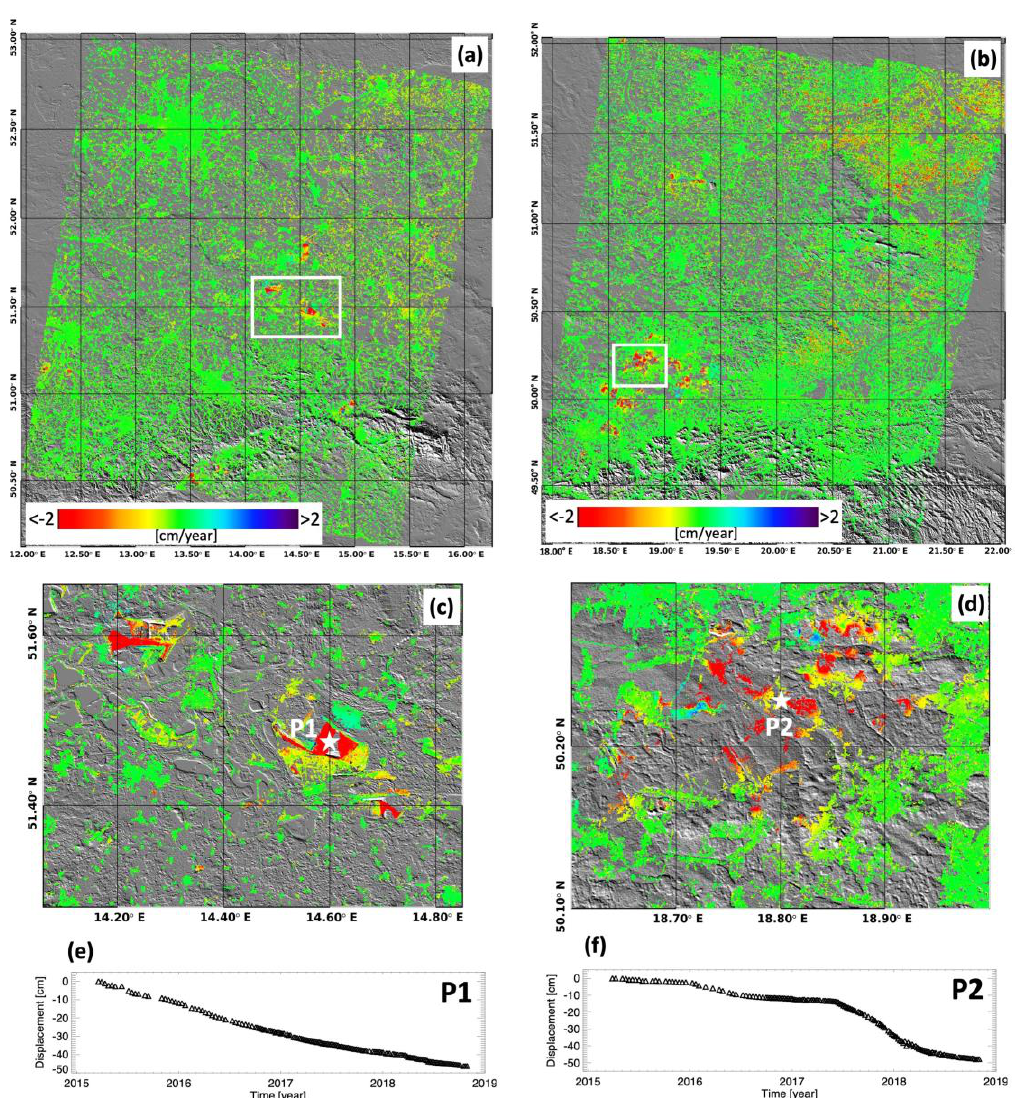
Figure 16. Zoomed-in views of the mean deformation velocity map relevant to two wide areas located in Germany ( a ) and Poland ( b ), both affected by extensive mining activities. ( a , b ) LOS mean deformation velocity map superimposed on the SRTM DEM of the zones; the white rectangles identify two areas that are shown in the panels ( c , d ). ( c ) Zoom of the LOS mean deformation velocity map in ( a ) relevant to the Nocthen coalmine (Germany). ( d ) Zoom of the LOS mean deformation velocity map in ( b ) relevant to the Katowice coalmine (Poland). ( e ) Displacement time series relevant to the pixel P1 marked by the white star in ( c ). ( f ) Displacement time series relevant to the pixel P2 marked by the white star in ( d ).